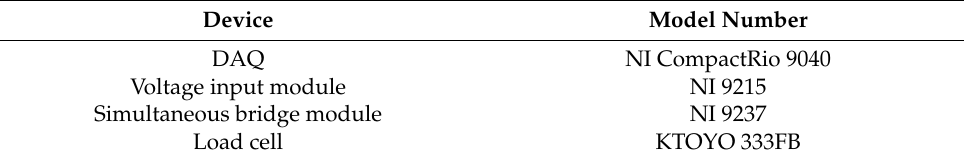
Table 6. Summary of equipment used in sensor characterization